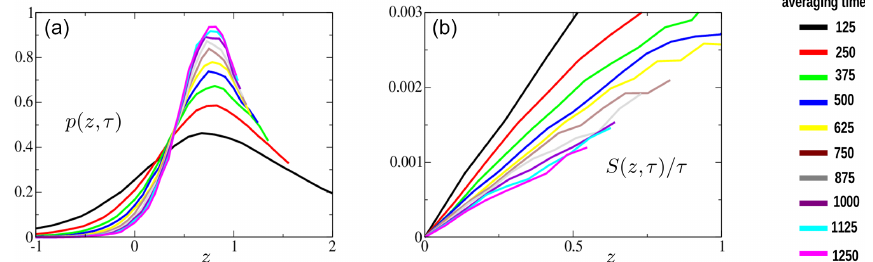
Figure 1. The pdf p(z,τ) (a) and the symmetry function normalized by the averaging time S(z,τ)/τ (b) as a function of z for different τ (see caption). The variable τ gives the length of the averaging interval in terms of observations done every 6h. Data are for case ASG, res 0.5 ◦ , 1993–2016, res 6h.